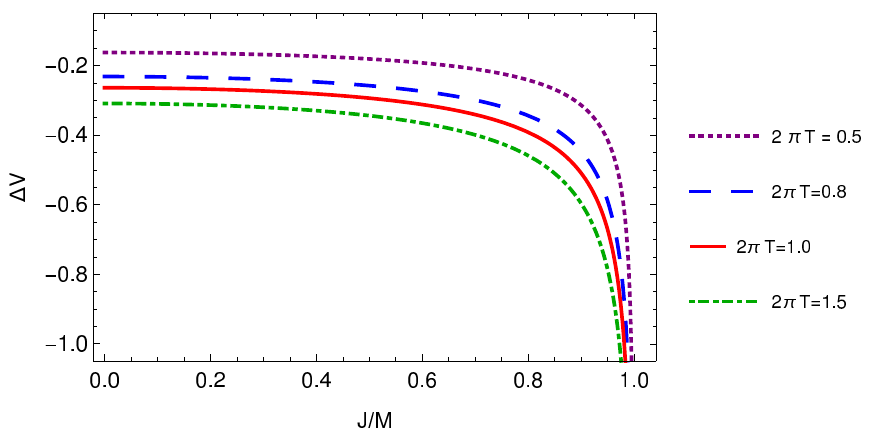
Figure 3 . Size of the opening of the wormhole as a function of angular momentum. We have set (cid:1) = 0 : 6.